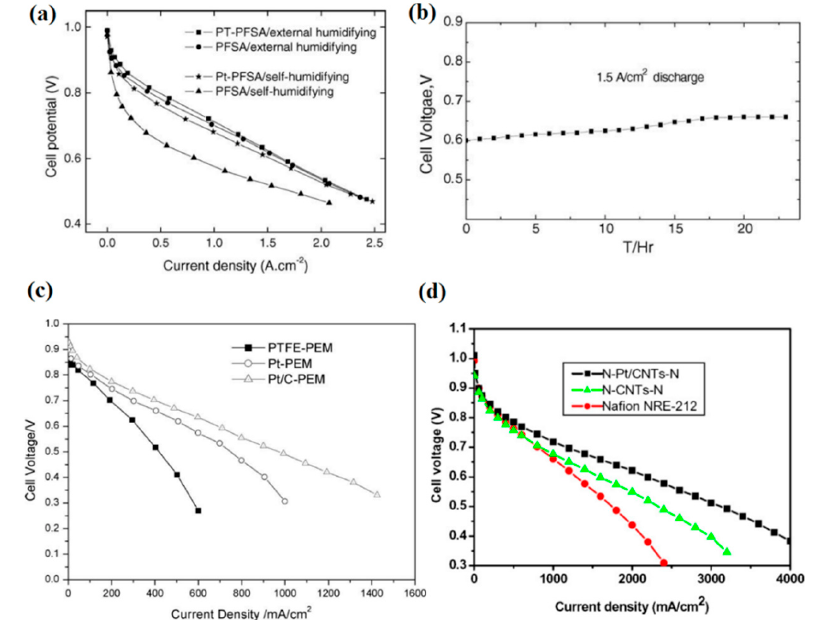
Figure 7. ( a ) I-V curves for plain and nanocomposite PEMs with a gradational Pt dispersion at 70 ◦ C and ( b ) stability test of Pt / PFSA membrane at a constant output current density for 24 h (reprinted with permission from [87]); ( c ) I-V curves for plain PEM and Nafion incorporated with Pt and Pt / C near the anode layer at 80 ◦ C and dry condition (reprinted with permission from [89]); ( d ) I-V curves for additive-free and three-layer nanocomposite Nafion with Pt / CNT or CNT at 80 ◦ C and dry conditions (reprinted with permission from